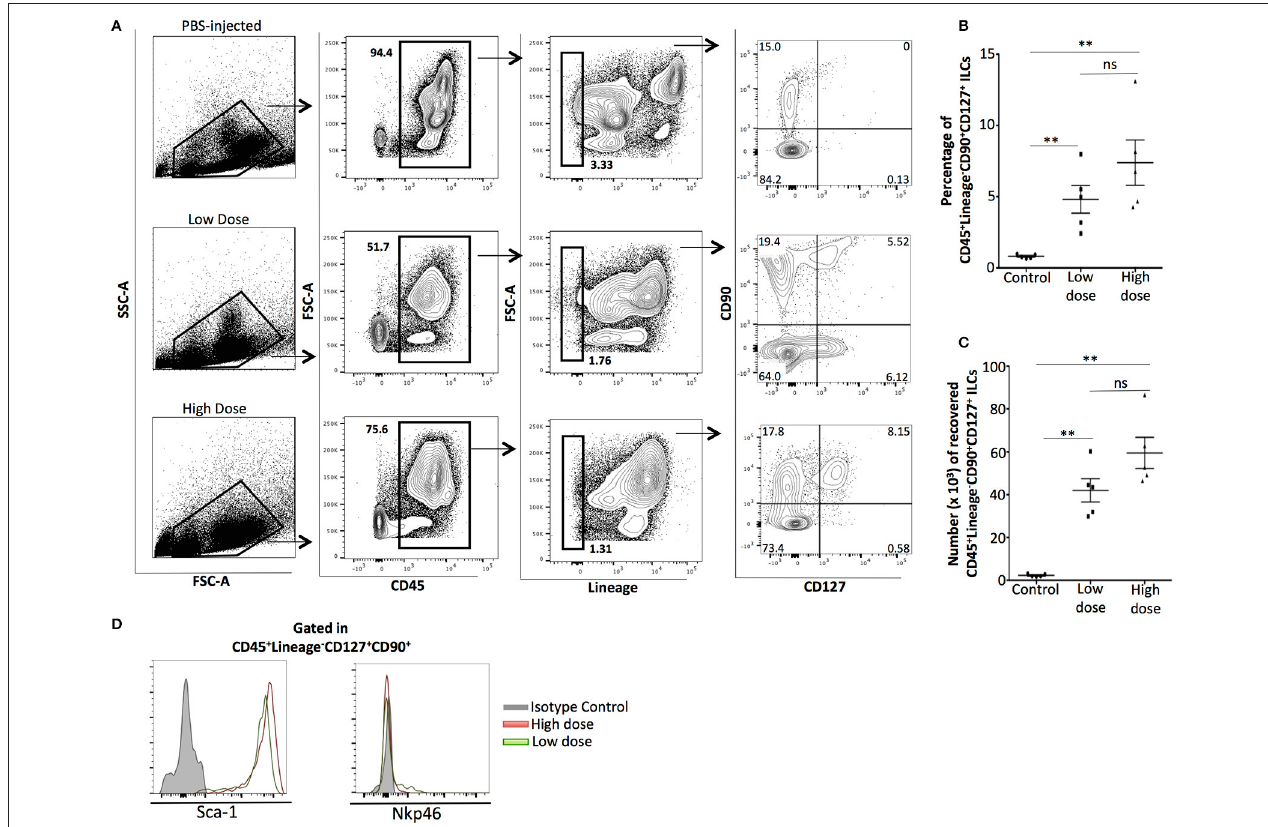
FIGURE 1 | Phenotypic analysis of innate lymphoid cells recovered from the peritoneal cavity of zymosan-injected mice, 24h post-injection. (A) Cells from the peritoneum of mice injected with PBS 1X (controls) or low (0.1 mg/ml) or high (10 mg/ml) dose of zymosan were recovered 24h post-injection. Cells were stained for CD45, Lineage, CD90, and CD127. One representative flow cytometry analysis is shown from 5 different independent experiments ( n = 5). (B) Significant increase in the frequency (percentage) of total ILCs (CD45 + Lin − CD90 + CD127 + ) cells emerged in the peritoneal cavity of zymosan-, but not in PBS-injected mice was observed ( n = 5) (C) No significant difference observed on the total cell number of ILCs between low- and high-dose treated mice ( n = 5), (D) ILCs recovered from the peritoneal cavity of both low- and high-dose of zymosan-treated mice were stained for additional markers including Sca-1 and Nkp46 and their expression level is shown ( n = 4). ** p <